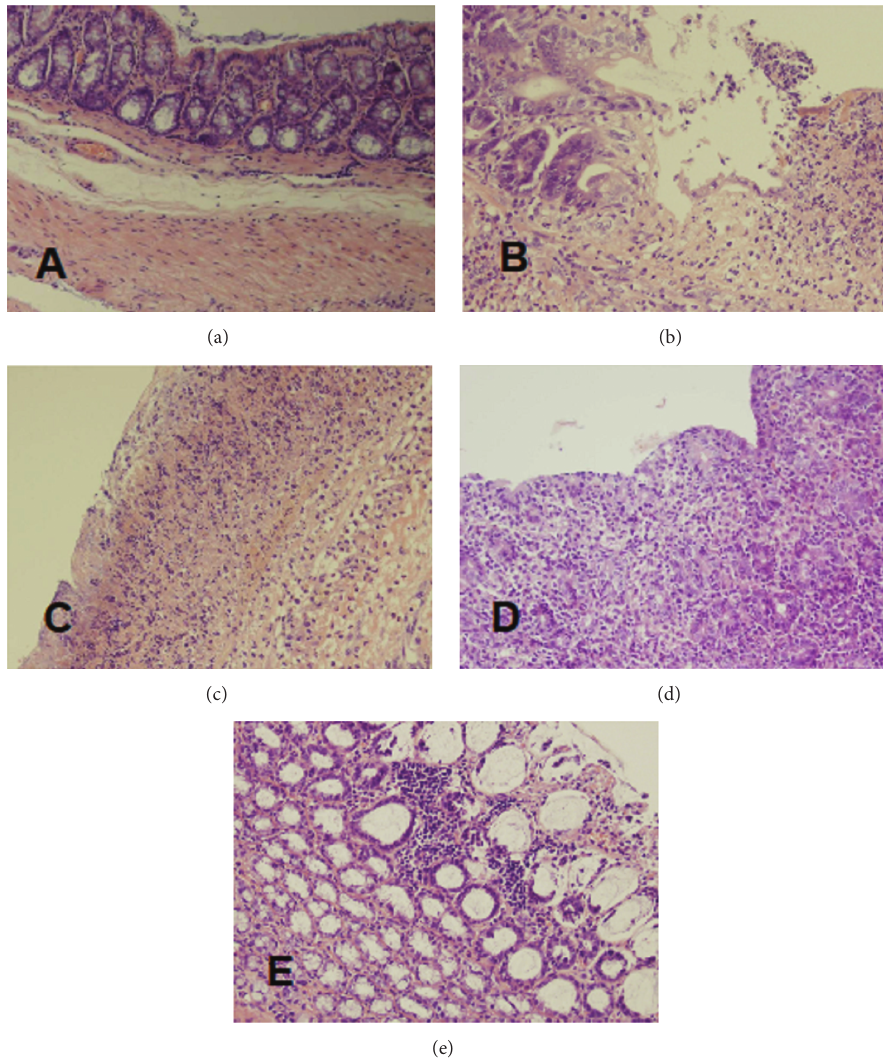
Figure 2: Histological features of the rat colonic mucosa stained by haematoxylin and eosin (original magnification 400x). (a) Control rats without induction of colitis and treated with saline for 7 days; (b) rats with colitis treated with saline for 7 days; (c) rats with colitis treated with Mutaflor for 7 days; (d) rats with colitis treated with rifaximin for 7 days; and (e) rats with colitis treated with the combination of rifaximin plus Mutaflor for 7 days.